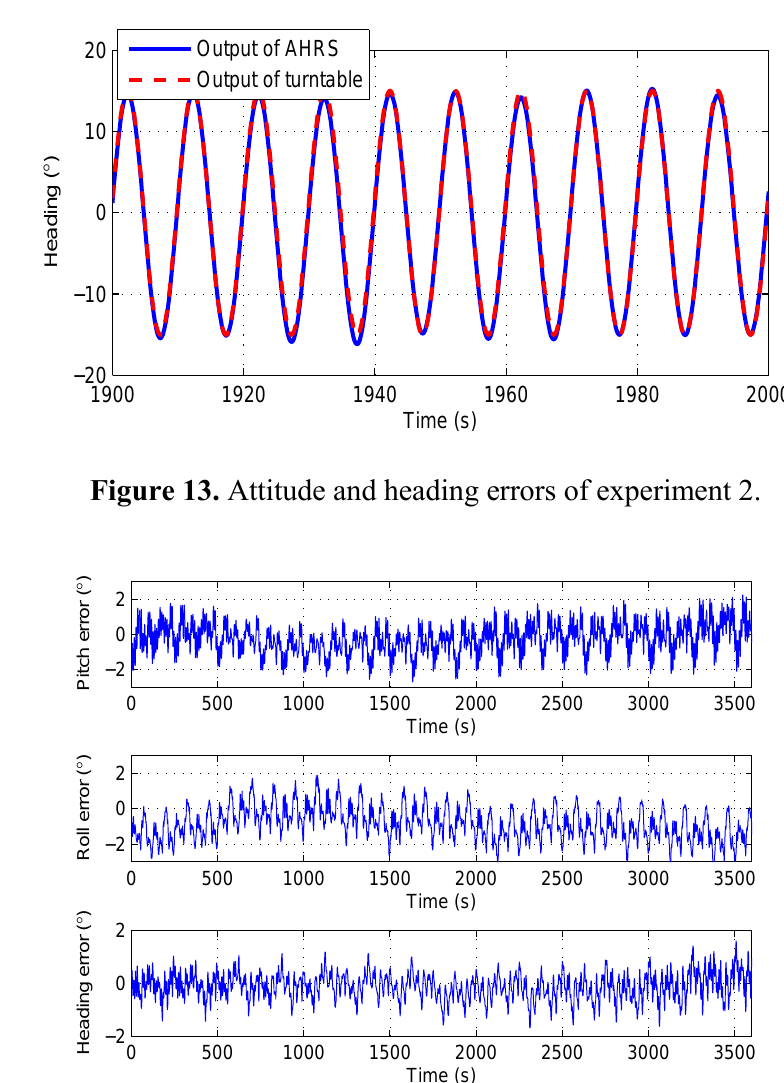
Figure 12. Heading comparison between the AHRS and the turntable.